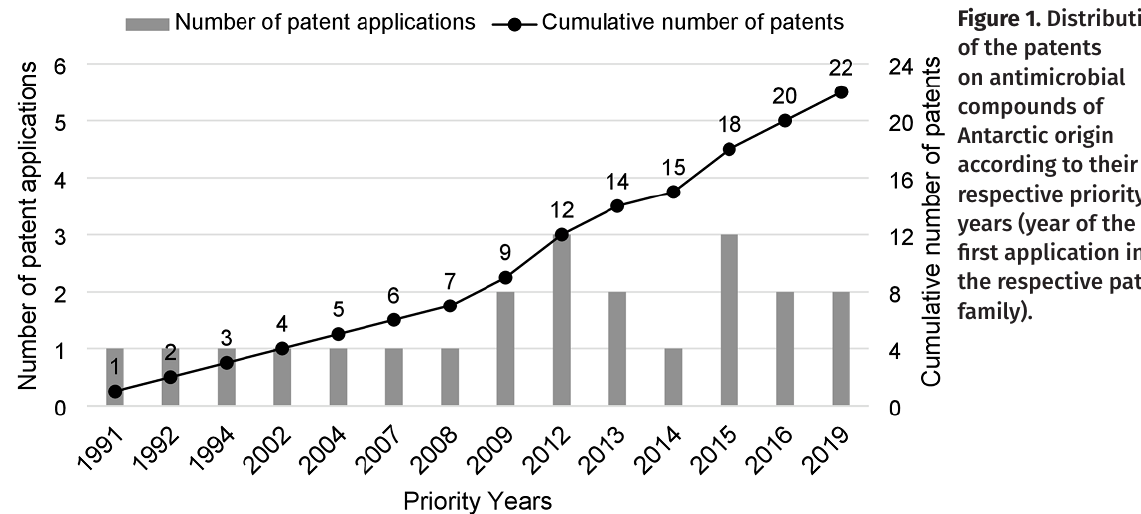
Figure 1. Distribution of the patents on antimicrobial compounds